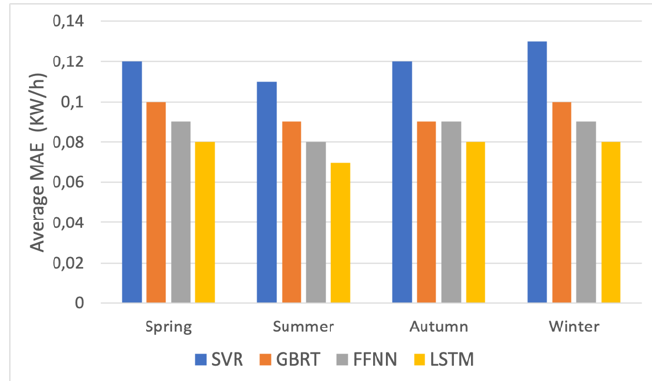
Figure 11. Comparison of models based on average MAE per season.